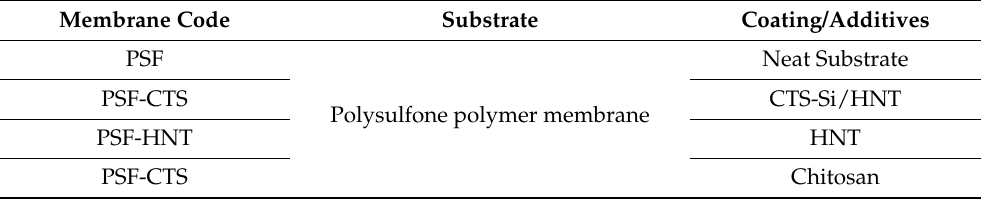
Table 1. Differently modified PSF substrates for contact angle analysis.